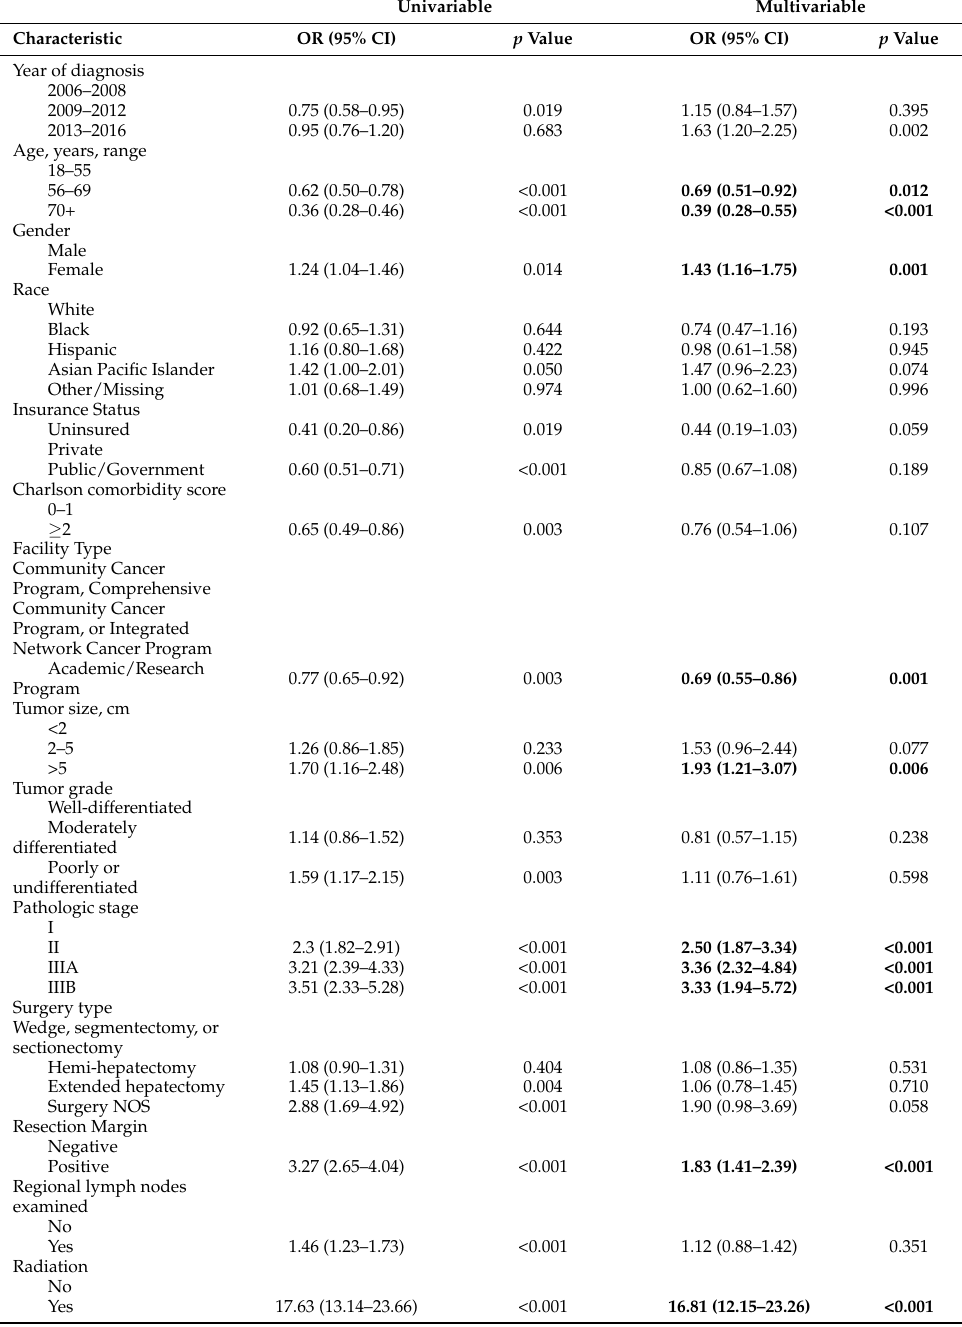
Table 3. Univariable and multivariable logistic regression analyses for factors associated with use of adjuvant